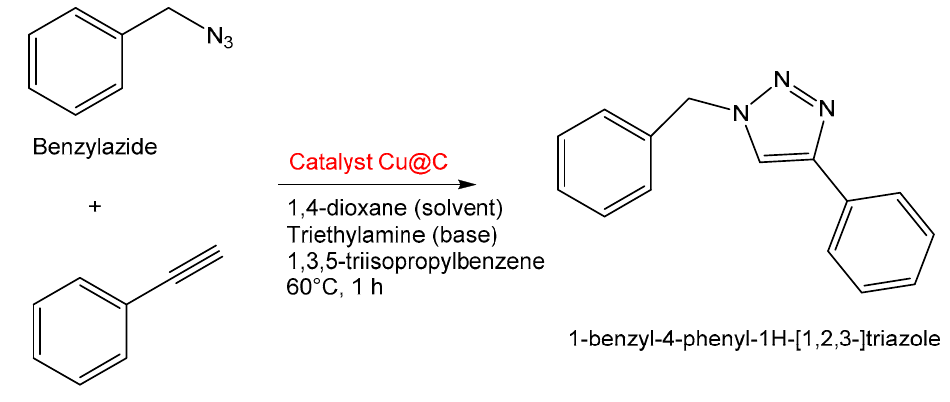
Figure 19. Cycloaddition reaction depicting the catalytic performance of Cu@C [119]. Fu et al. created a copper MOF in reduced form (rCu-MOF). Many ‘click’ reactions were carried out with high yield using this reduced Cu-MOF (Figure 20). The rCu-MOF catalyst was shown to be more active than the traditional copper halide catalyst, with the added benefit of being easily recyclable (Table 6). rCu-MOF is appealing as a catalytic material for industrial applications due to these features as well as due to its simplicity of synthesis, absence of metallic contamination, and great mechanical constancy. This research paves the way for further exploration of rCu-MOFs in polymer chemistry [120].